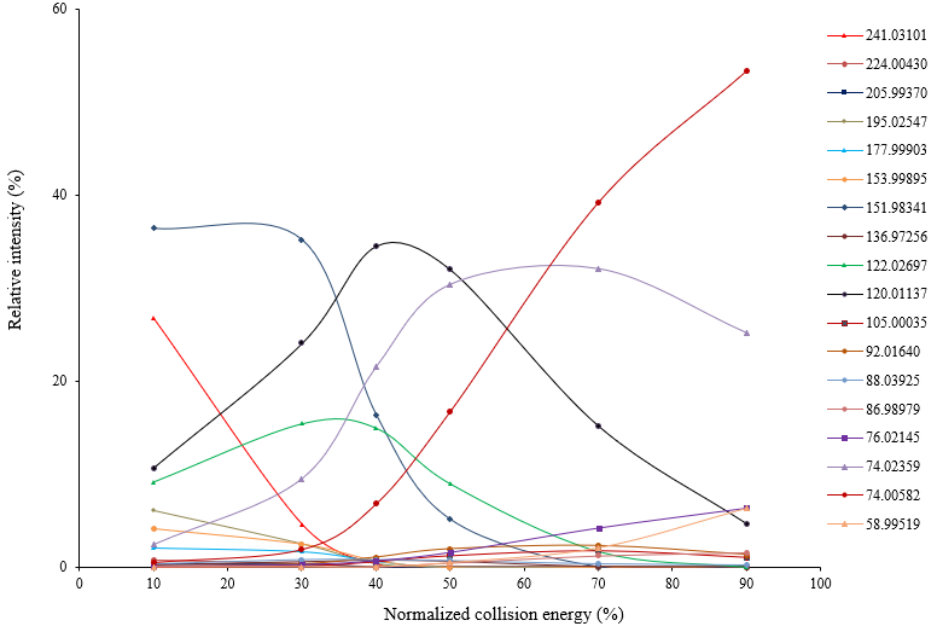
Figure 1. Energy-resolved fragmentation graph of protonated cystine under different collision energies.